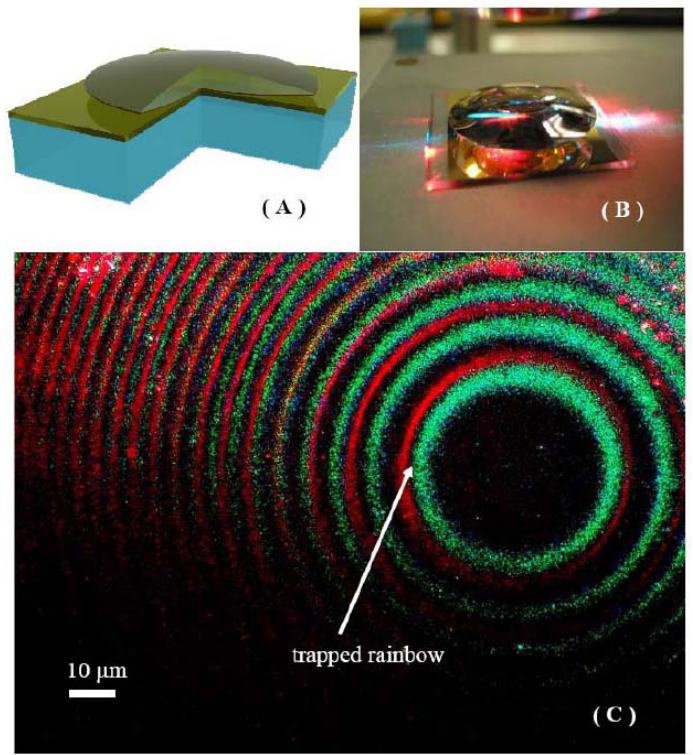
Figure 5. ( a ) Experimental geometry of the trapped rainbow experiment: a glass lens was coated on one side with a gold film. The lens was placed with the gold-coated side down on top of a flat glass slide also coated with a gold film. The air gap between these surfaces formed an adiabatically changing optical nano waveguide. ( b ) Photo of the trapped rainbow experiment: HeNe and Ar:Ion laser light is coupled into the